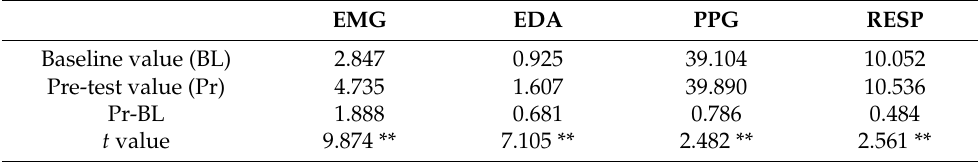
Table 2. The t -test of EMG, EDA, PPG, and RESP at tranquility and stress inducement. EMG